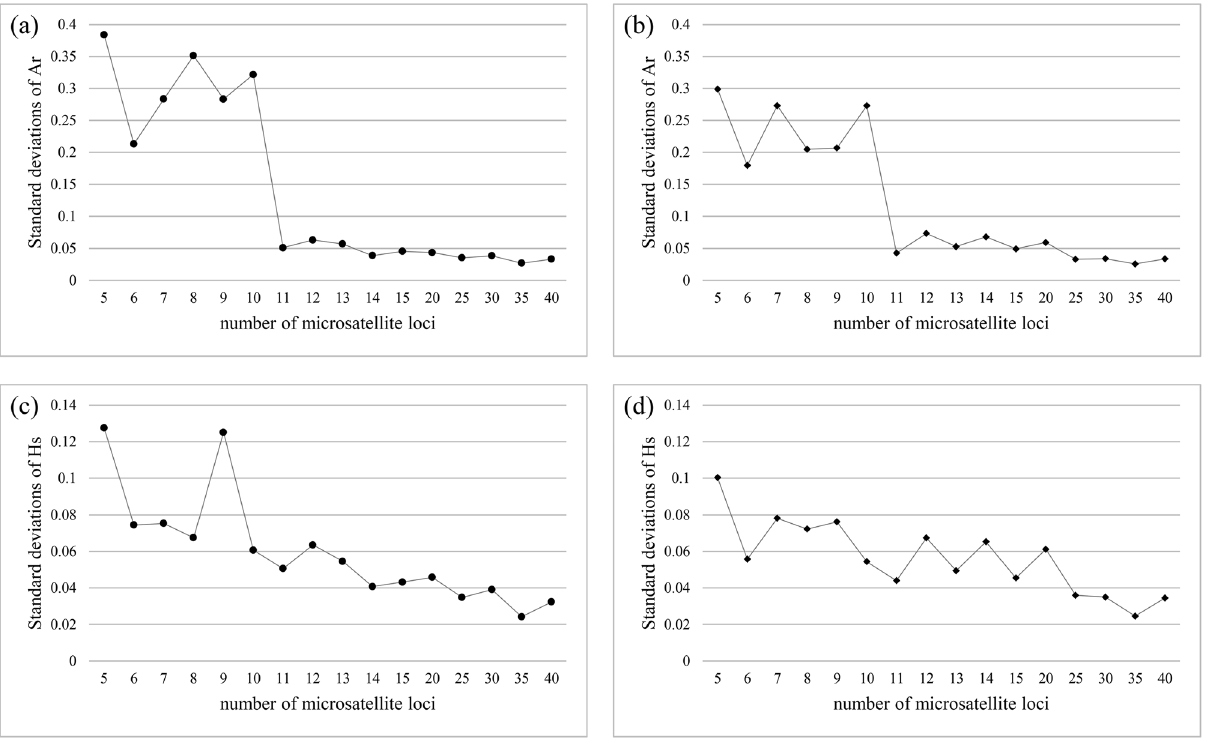
Figure 2. Standard deviation of allelic richness (Ar) and genetic diversity (Hs) per locus in R. dauricum ( a , c ) and R. mucronulatum ( b , d ), respectively.